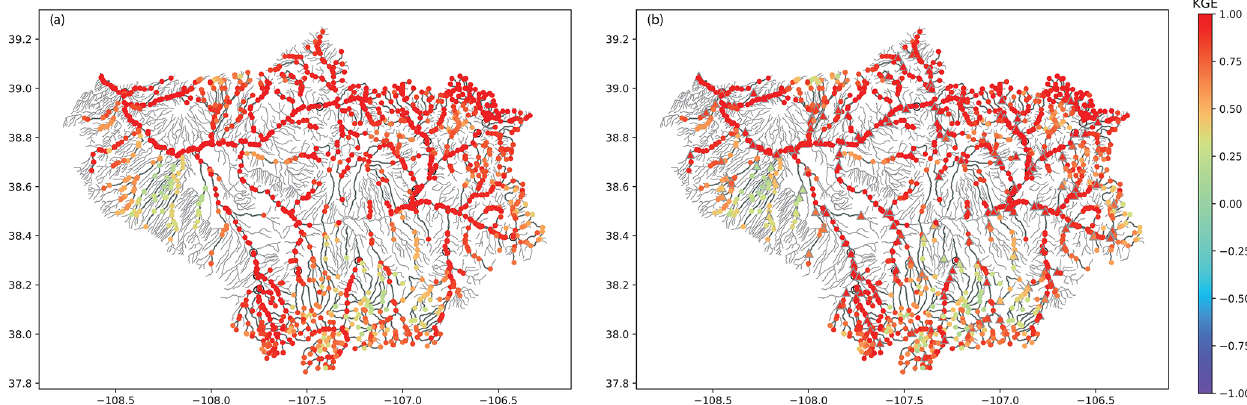
Figure 12. The node KGE maps obtained using (a) 1708-node GWN and (b) 225-basin GWN-Impute models for the testing period. Panel (b) shows the locations of the subbasins that are labeled as